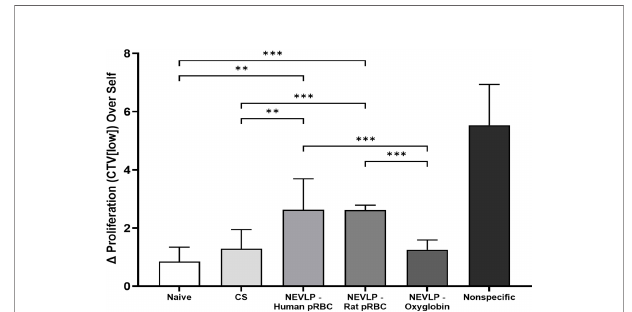
FIGURE 6 | Allogeneic MLR responses are elevated after NEVLP with human pRBC or rat pRBC. Lymph node-derived Brown Norway leukocytes were cocultured with irradiated Lewis liver-resident immune cells isolated from control (naive, CS) or experimentally perfused (NEVLP-Human pRBC, NEVLP- Rat pRBC, NEVLP-Oxyglobin) livers. The MLR response was measured after 4 days in culture by the delta ( D ) increase of T-cell (CD3+) proliferation over an autologous (Brown Norway liver-resident immune cell stimulator) internal control. Statistical comparisons between allogeneic conditions (Lewis- stimulated) are shown (**p < 0.01, ***p < 0.001). The nonspeci fi c positive control, stimulated with T cell-activating antibodies (anti-CD3/anti-CD28), yielded a signi fi cant (p < 0.001) increase in T-cell proliferation compared to all allogeneic conditions. Triplicate data were derived from n = 4 for Oxyglobin, n = 3 for human pRBC, and n = 2 for naive, CS, rat pRBC, and nonspeci fi c